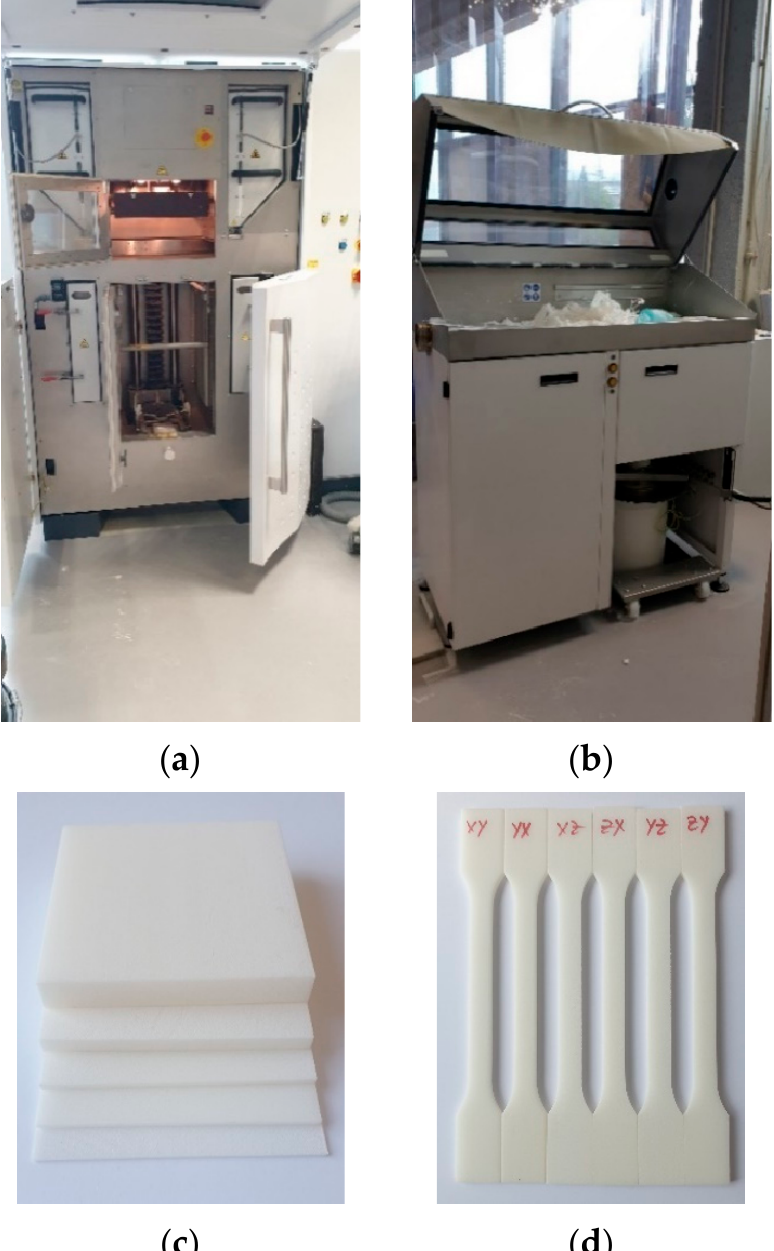
Figure 1. EOS P 396 printer ( a ) and post-processing machine ( b ) at Baltic3D.eu factory; the samples printed in the direction of XY ± 45° at different thicknesses of 1.00, 1.75, 2.00, 5.00, and 10.00 mm ( c ) and dog-bone samples for tensile tests ( d ).